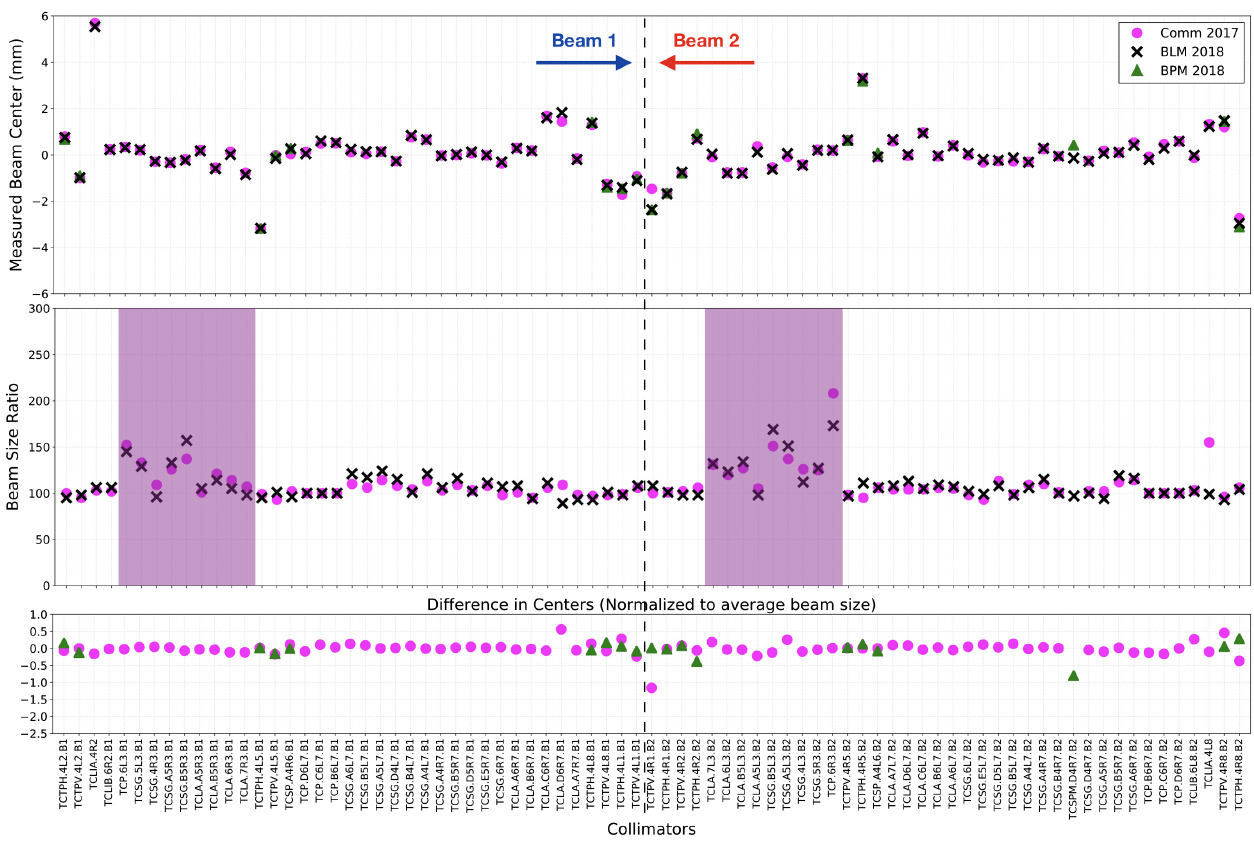
FIG. 8. Injection BLM commissioning 2018 results, comparing the beam centers to 2018 BPM centers and 2017 BLM centers (top graph), and beam size ratios compared to 2017 (middle graph). The beam size ratios in IR3 are shaded as they are expected to be large due to the higher dispersion in that location. Finally the differences between the 2018 BLM centers and the rest are compared after normalization by the average beam size of 2017 and 2018 (bottom